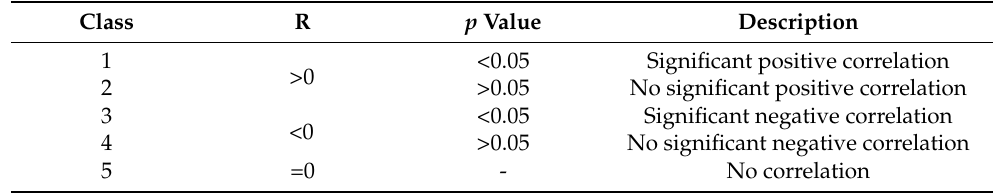
Table 3. Classification of correlation